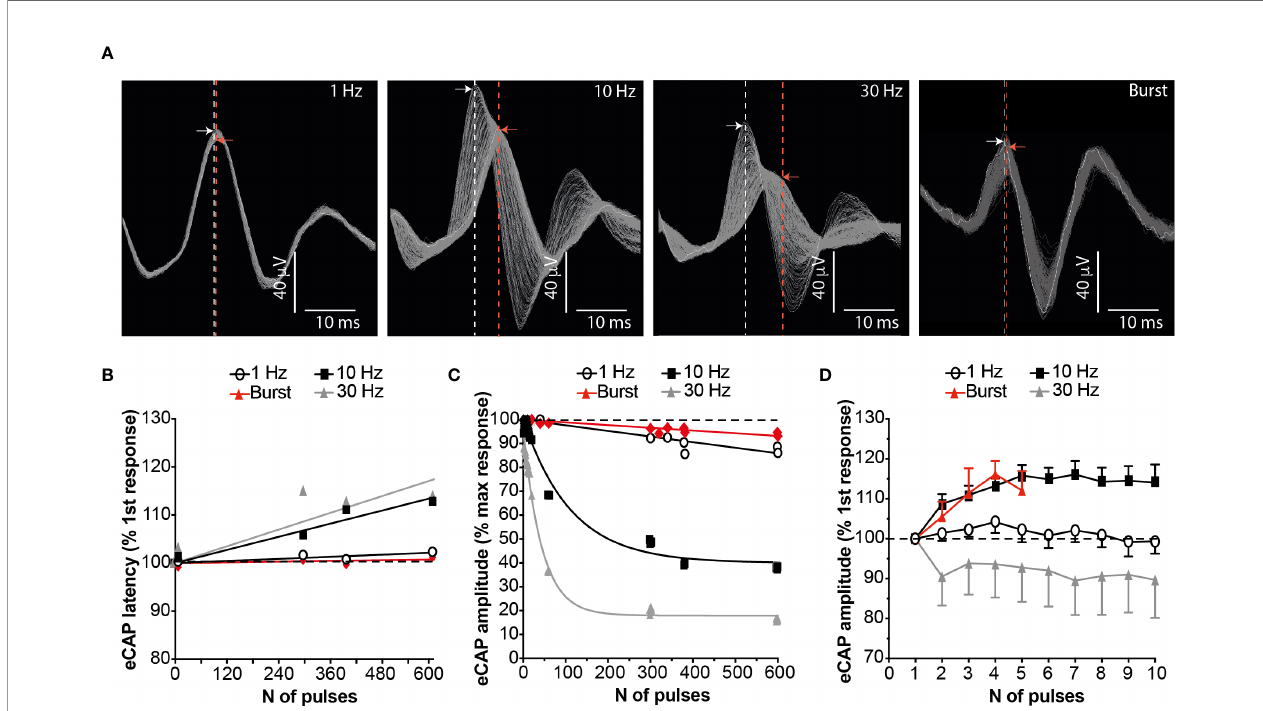
FIGURE 1 | Burst Stimulation (10 Hz; 0.5s on 4.5s off) Sustains SpN Activation. (A) Representative SpN eCAPs obtained when stimulating the SpN at 1, 10, 30 Hz or 10 Hz burst (5 pulses delivered at 10 Hz, with a 4.5 s delay between bursts). Each image shows 300 consecutive pulses overlapped. The stimulation artefact was removed for clarity. The dashed lines indicate the latency of the peak of the fi rst (white line) and last (red line) recorded eCAP. The arrows indicate the amplitude of the peak of the fi rst (white arrow) and last (red arrow) recorded eCAP. (B) Quanti fi ed eCAP amplitude (expressed as percentage of the max response) over 600 consecutive pulses with the different pattern of stimulations shown. Data are shown as mean (n = 3). Least-squares regression curves were fi tted against the data. (C) Quanti fi ed eCAP latency (expressed as percentage of the fi rst response) over 600 consecutive pulses with the different pattern of stimulations shown in (A) . Data are shown as mean (n = 3). Least-squares regression curves were fi tted against the latency data. (D) eCAP amplitude (expressed as percentage of the fi rst response) over the fi rst 5-10 pulses with the different pattern of